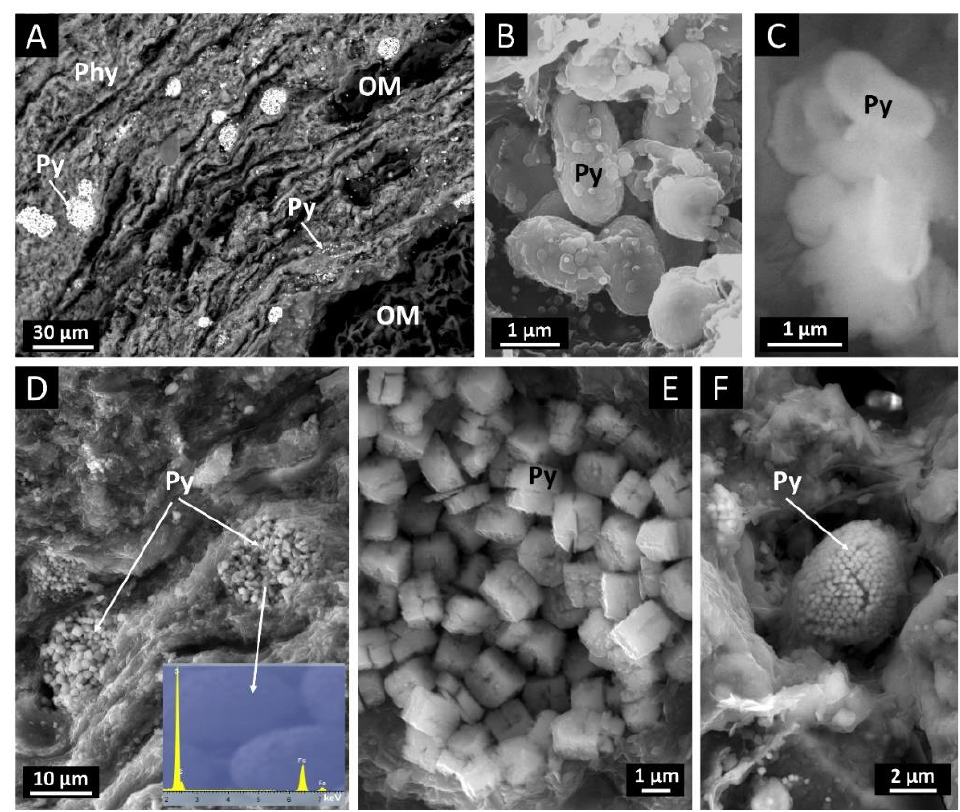
Figure 3. FESEM and EDX images of pyrite from sediments of La Playa dam: ( A ) disrupted organic matter microbands alternating with clay-rich microlaminae (BSE image)(sample LP7); ( B ) and ( C ) pyrite cell-shape aggregates (sample LP7); ( D ) pyrite framboids from permanently flooded sediments (sample LP7); ( E ) pyrite hopper crystals from permanently flooded sediments (sample LP7); ( F ) pyrite microframboids with honeycomb disposition crystals in periodically emerged sediments (sample LP8). Phy: phyllosilicates; Py: pyrite; OM: organic matter.